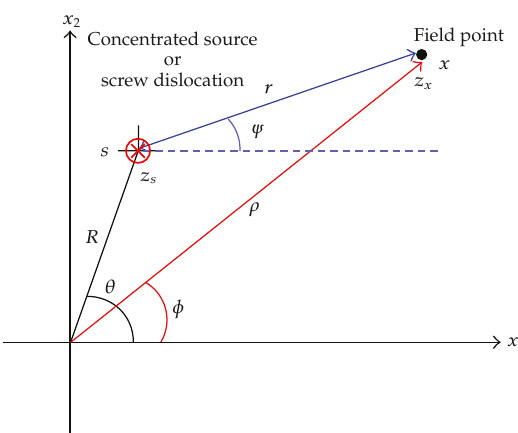
Figure 2: Sketch of the concentrated source and the screw dislocation.